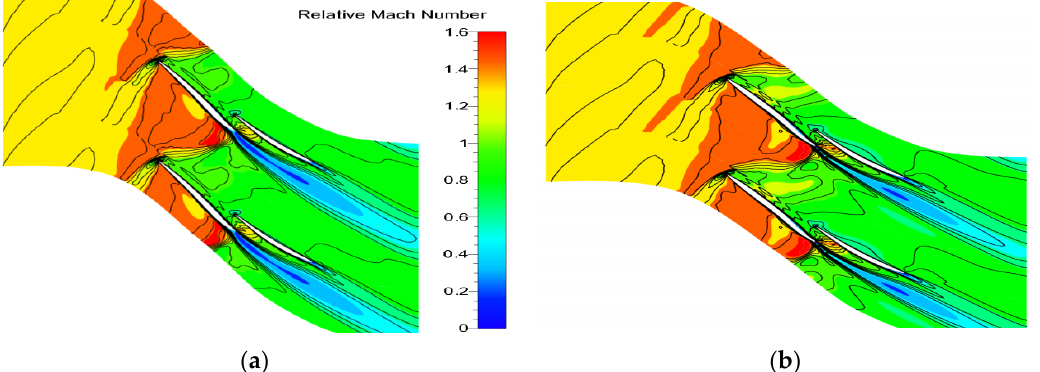
Figure 12. The relative Mach number of 50% span of the original and optimized tandem rotor. ( a ) ORG; ( b ) OPT.